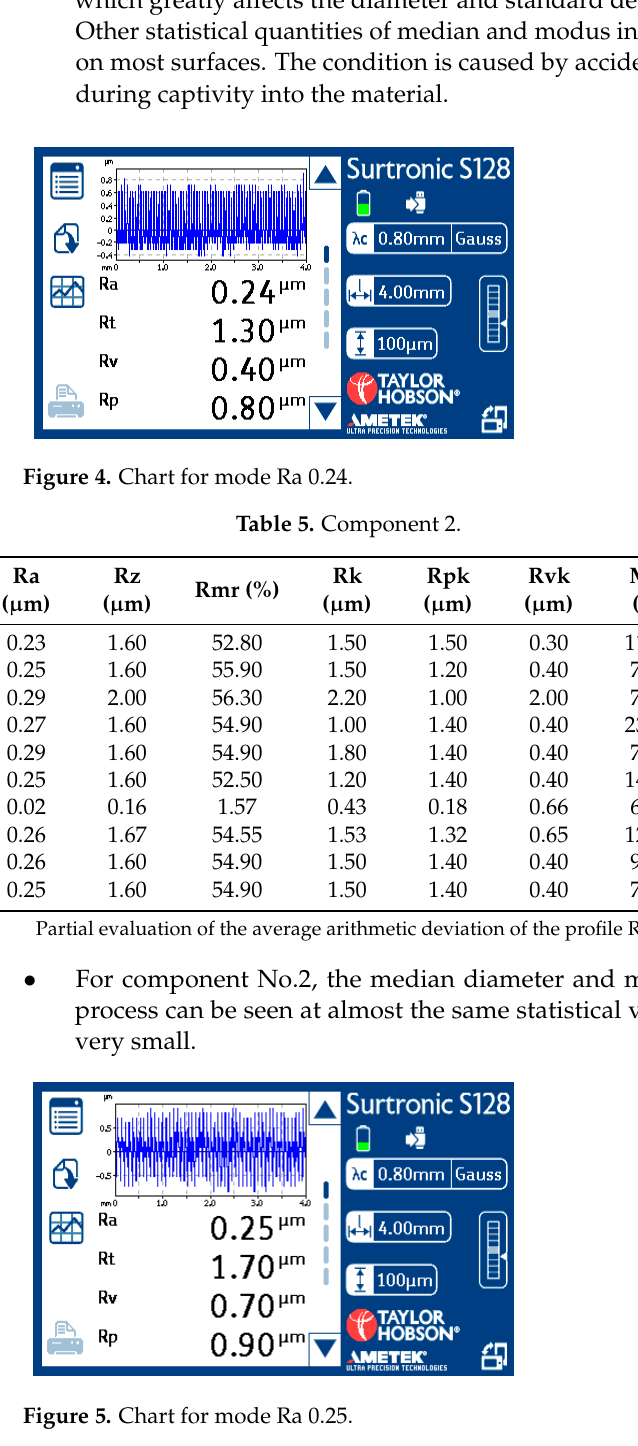
0.50 Figure 6. Chart for mode Ra 0.6. Partial evaluation of the average arithmetic deviation of the profile Ra: • Component No.1 is the extreme negative surface roughness value for three measure- ments and a very good value for measurements for No.4. The condition is caused by